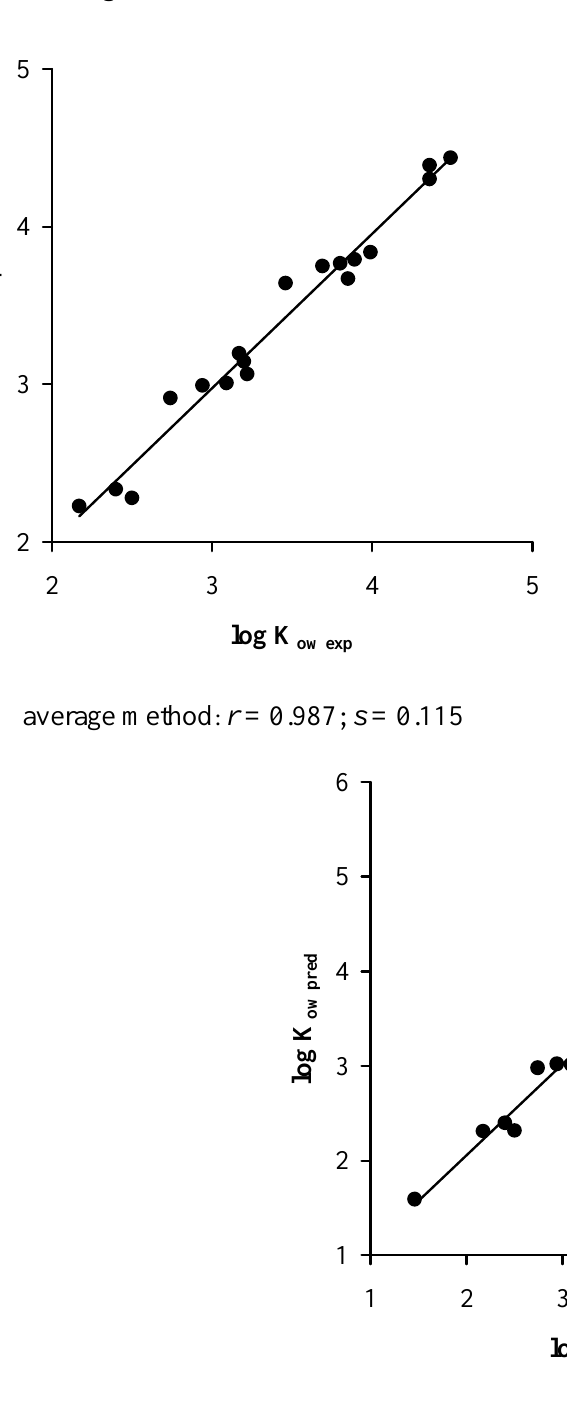
Figure 3. Plot of experimental vs. predicted octanol/water partition coefficient for chlorophenols with the poset-average, cluster-expansion, and splinoid poset QSSPR